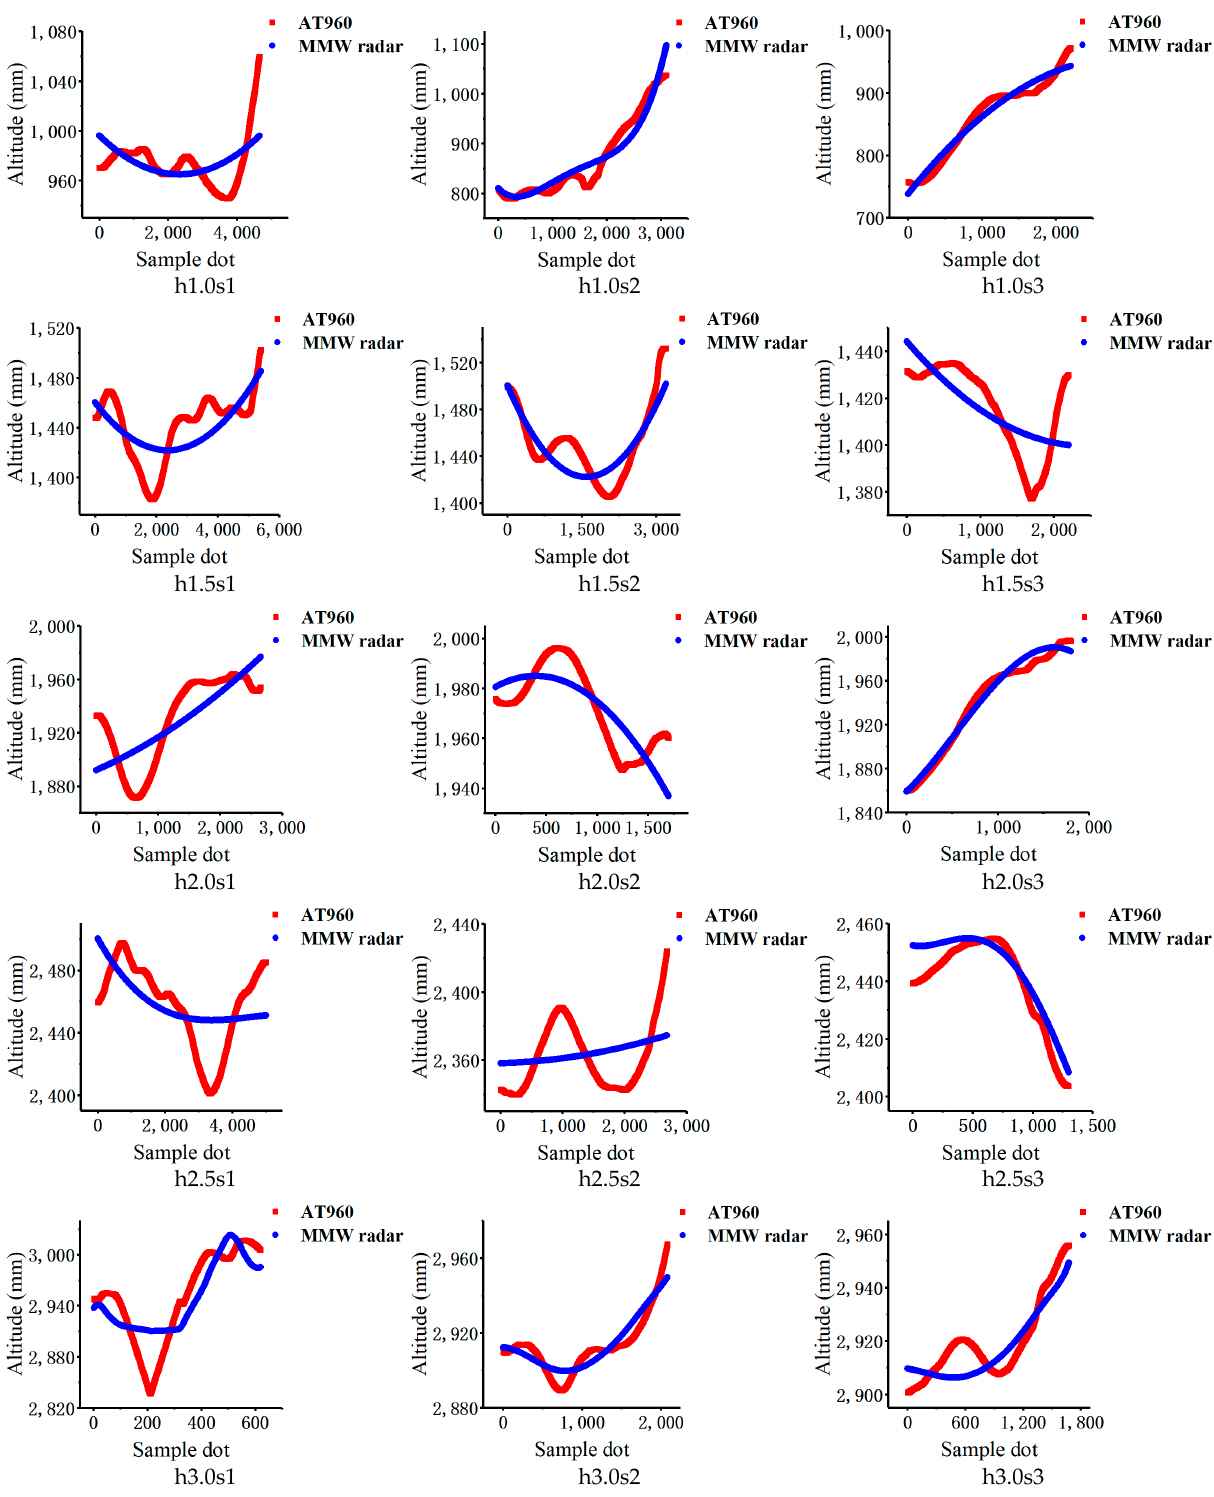
Figure 8. Flight altitude.